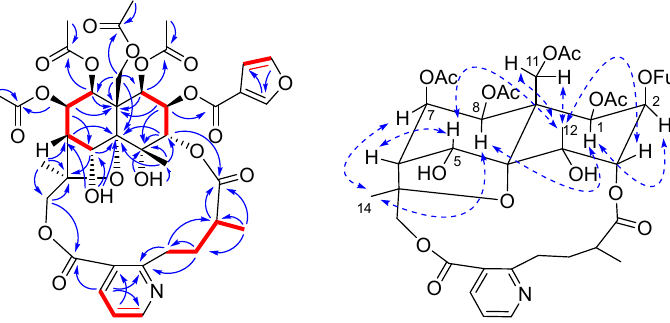
Figure 2. Key 2D NMR correlations of 1 [red lines for 1 H- 1 H COSY, blue arrows for HMBC (from H to C), dashed two-way arrows for ROESY].